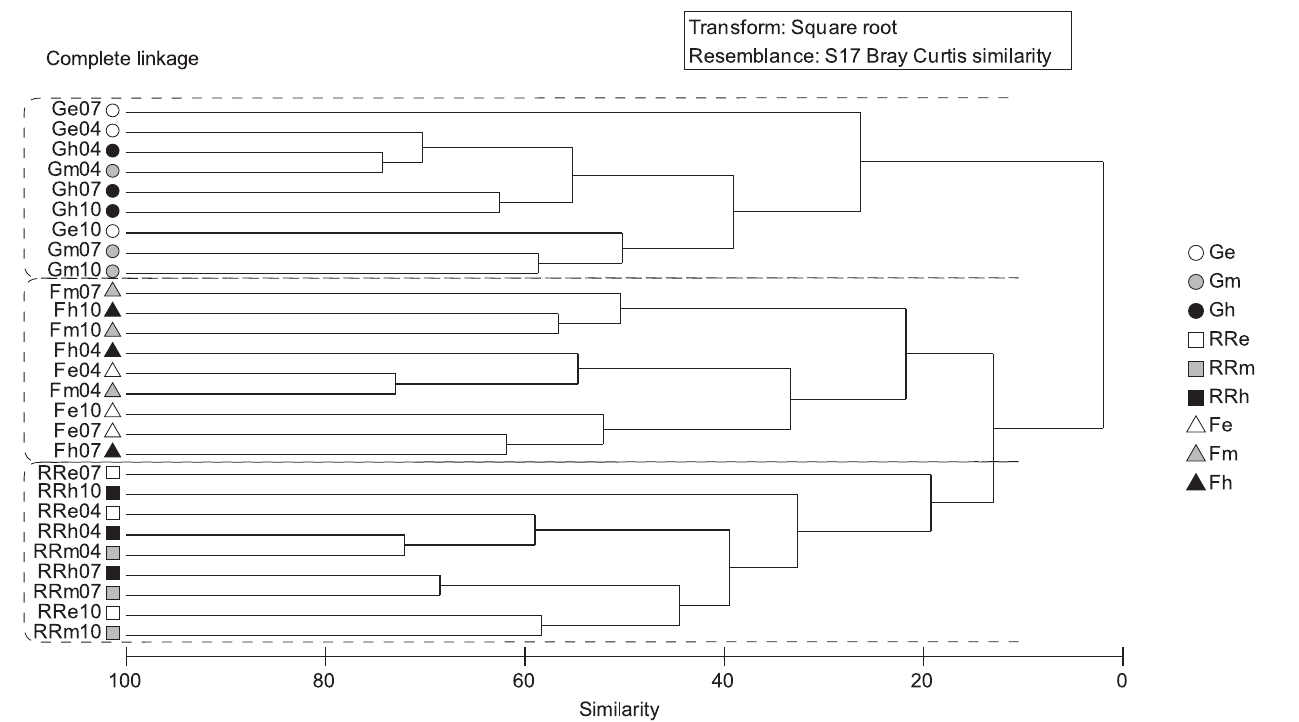
Fig. 3. Clustering analyses. Hierarchical clustering analyses of Bray-Curtis similarities of the community composition at OTU level (0.03 cut-off) in the three reservoirs. Legend: G, La Gileppe (dots); RR, Ry de Rome (square); F, Fe´ronval (triangles); e, epilimnion (white); m, metalimnion (grey); h, hypolimnion (black); 04, April 2010; 07, July 2010; 10, October